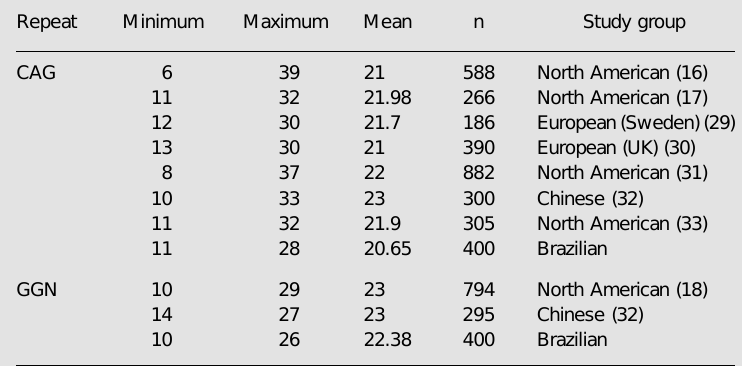
Table 3. CAG and GGN repeats in different populations.